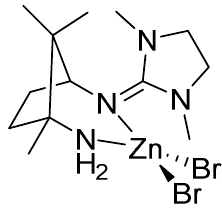
Figure S2: MALDI-ToF measurement for polymerization c after 7 h. Conditions: 1000:1 ([Zn(DMEGca)Cl 2 ], C2 ):10 [BzOH], 140 ◦ C, 400 rpm, recrystallized rac -lactide. M n = 8000 g/mol, M w = 9500 g/mol, Đ =